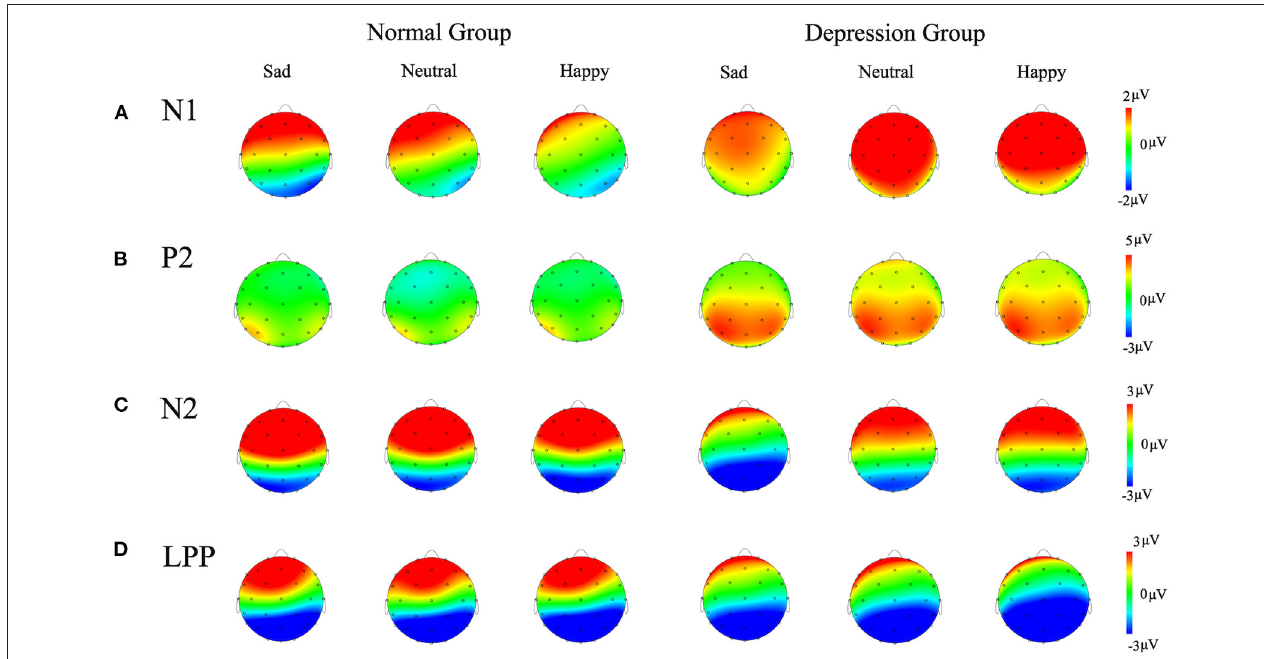
FIGURE 3 | Topography maps of the difference waves (A) N1 component, (B) P2 component, (C) N2 component, (D) LPP component are shown in the different groups for different